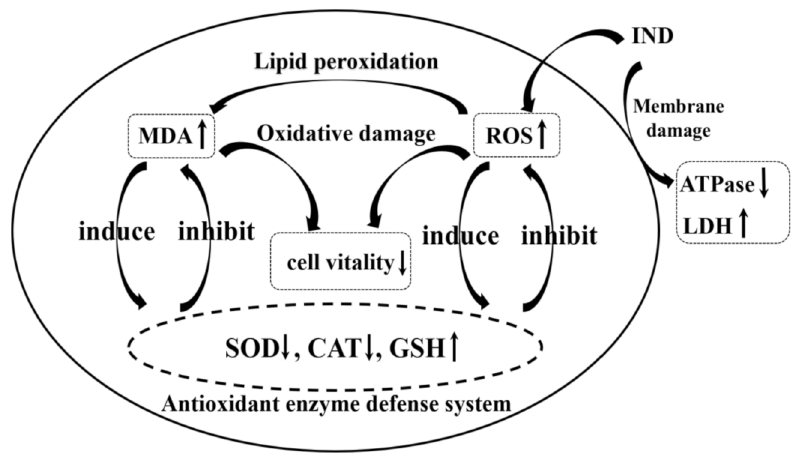
Figure 8. The diagram of the relationship of oxidative stress indexes. The arrow represents the effect of the former on the